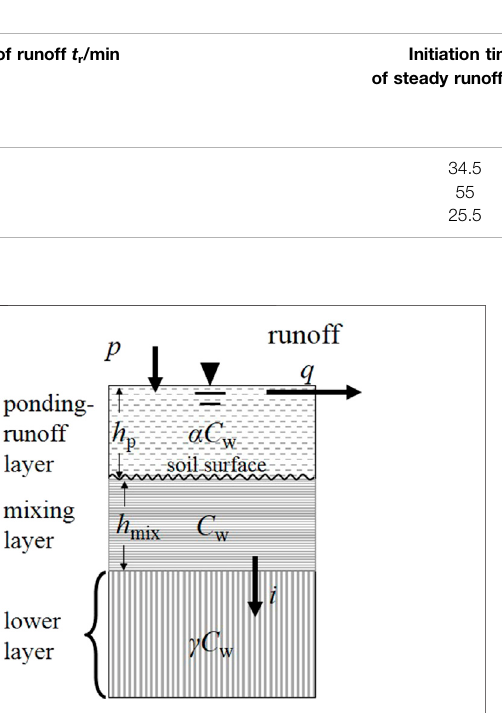
FIGURE2 | Simpletwo-layer incomplete mixing model (Non-actualsize) (Tong et al., 2010).